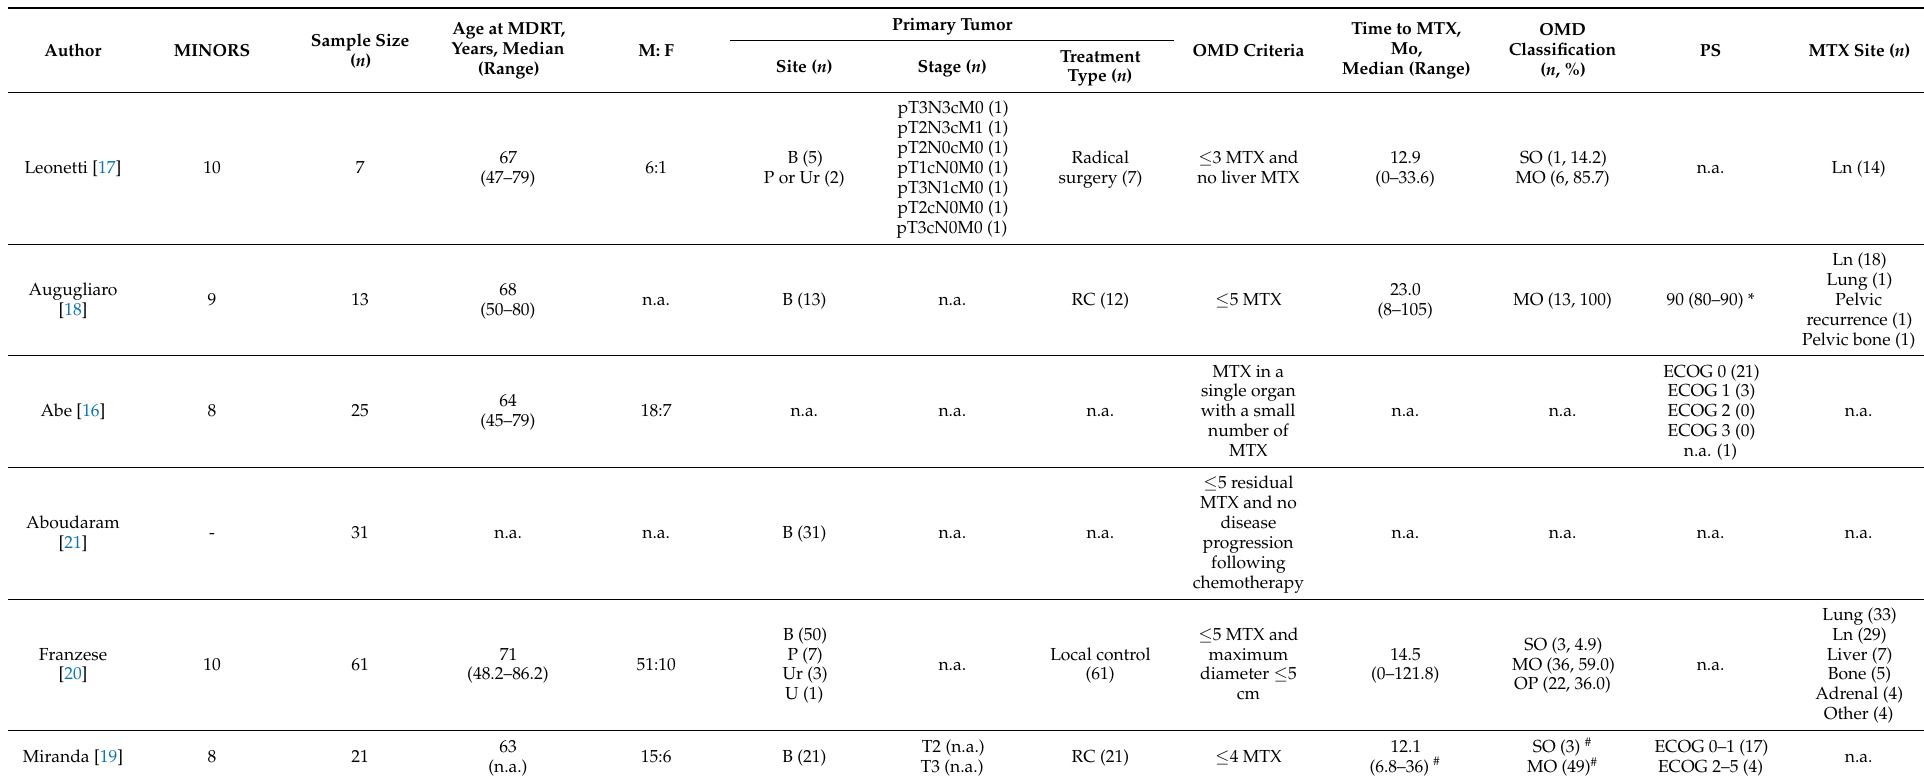
Table 1. Study characteristics and clinico-pathological features of the patients